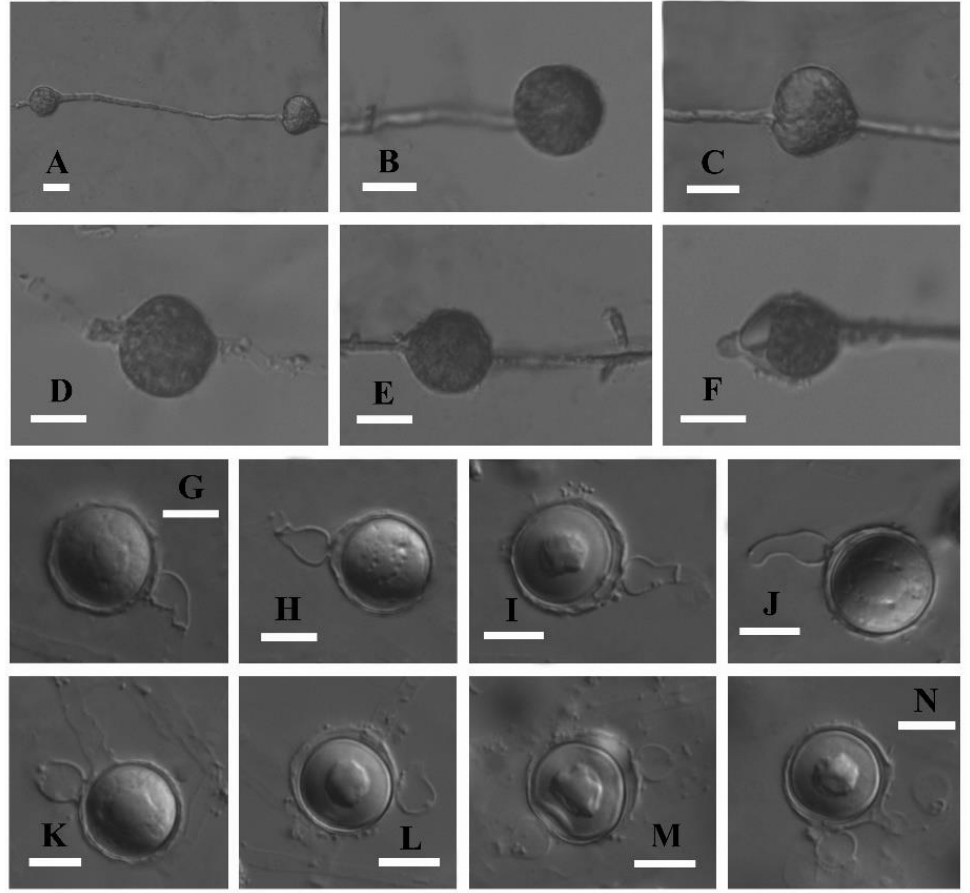
Figure 3. Asexual and sexual reproductive bodies of Globisporangium pengfuense (holotype, Chen 93). ( A) Catenulate sporangia. ( B ) Globose and terminal sporangium. ( C – E ) Intercalary sporangia. ( F ) Sporangium with apical papillae. ( G ) Diclinous antheridium and plerotic oospore. ( H , I ) Fist-shaped antheridial cells. ( J ) Crook-necked antheridial cell. ( K ) Monoclinous antheridium. ( L ) Intercalary oogonium. ( M ) Nearly plerotic oospore and two antheridia. ( N ) Plerotic oospore and three antheridia. Scale Bars A – N = 10 μm.